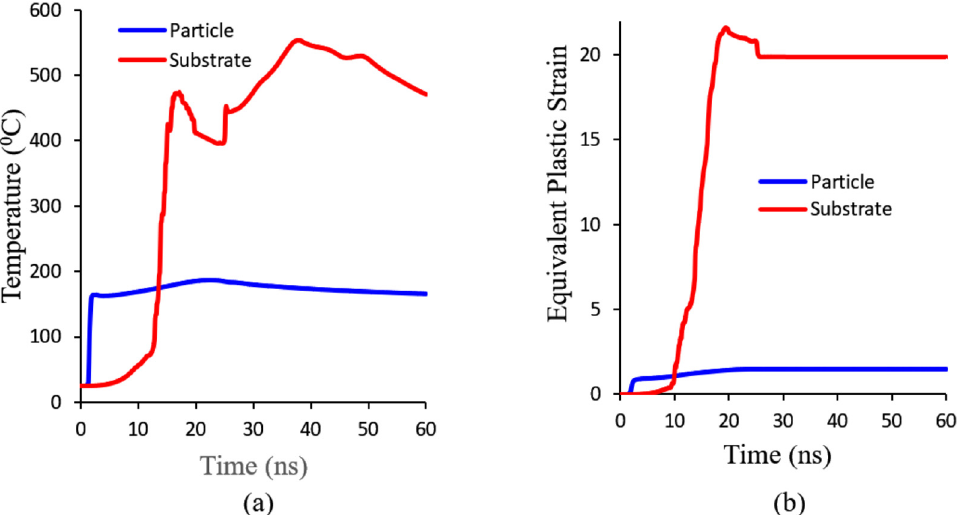
Fig. 9. The time distribution of (a) The temperature (b) The PEEQ of Cu/Al impact at 500m/s impact velocity using the ALE numerical